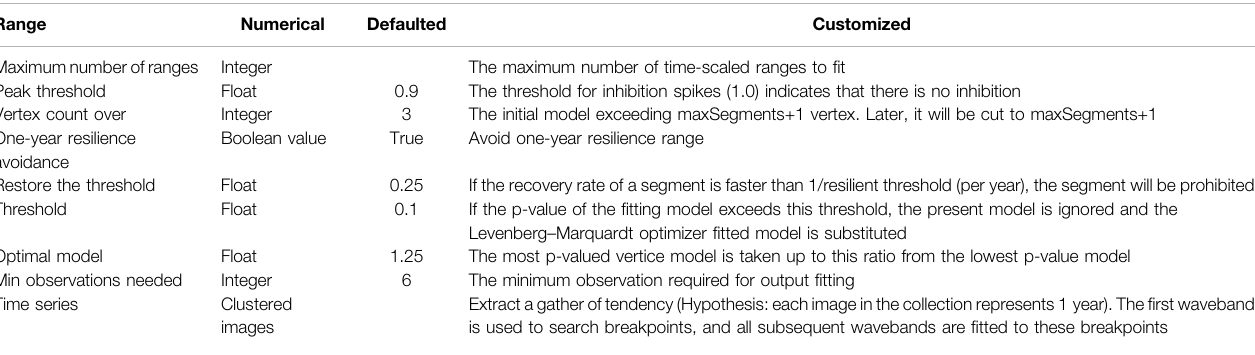
TABLE 2 | LandTrendr key parameter